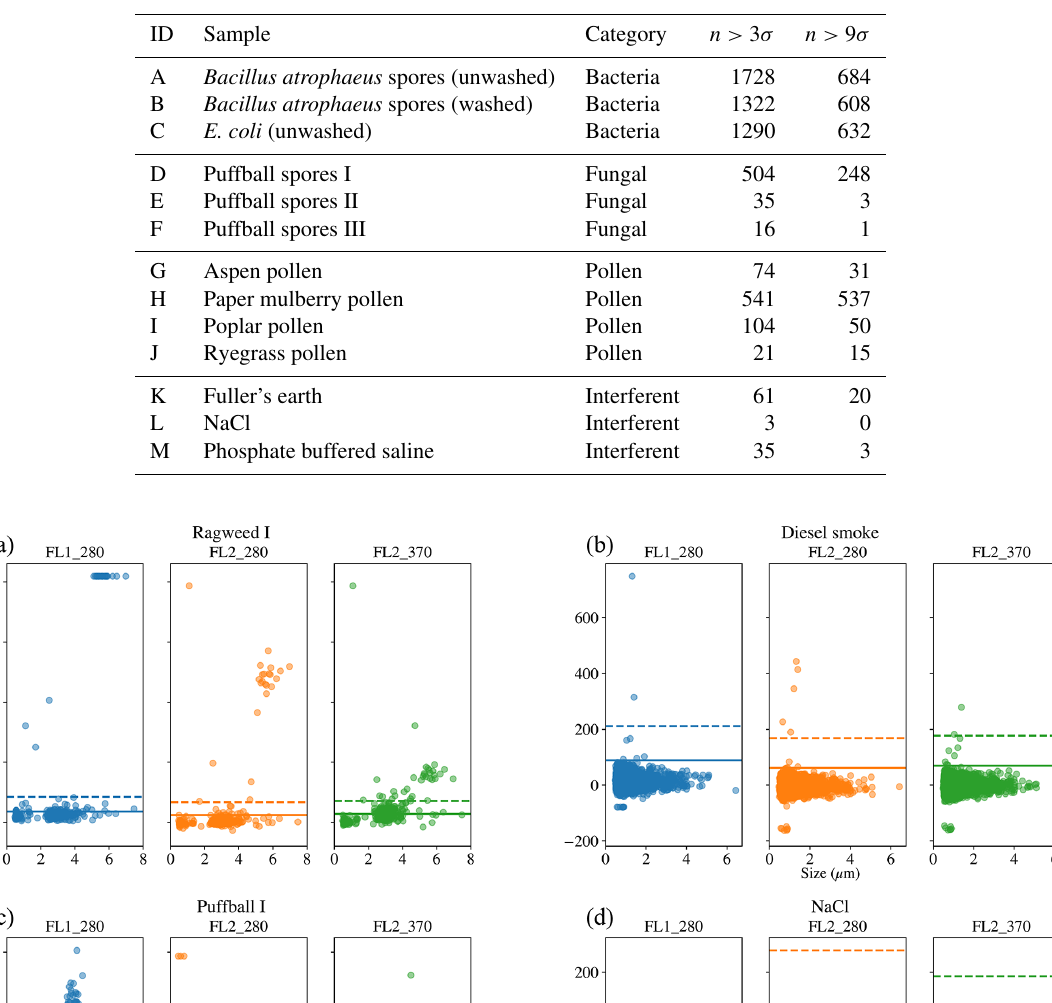
Table 3. The number of particles remaining after a fluorescent threshold was applied to each of the samples collected in 2014. Whether a bacterial sample was washed or unwashed is specified after the sample name.